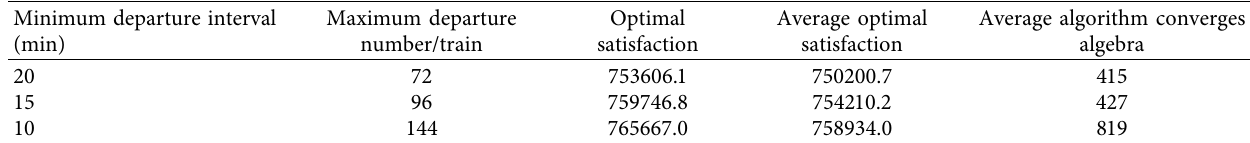
Figure 5: Algorithm iteration result graph with 10 min departure interval. Table 4: Scheme comparison with different departure interval constraint.